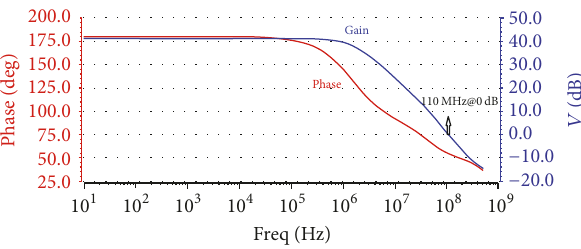
Figure 6: Simulated frequency response of differential